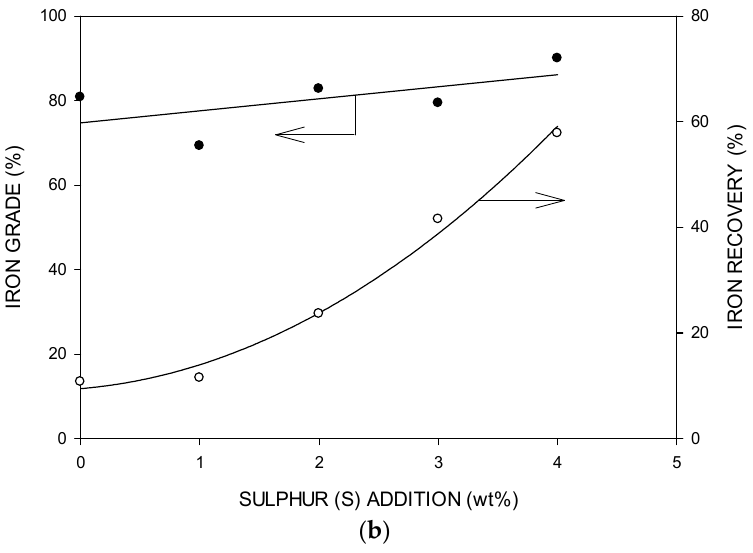
Figure 13. ( a ) Effect of sulphur additions on nickel grade and recovery at a magnetic field strength of 3 kG; ( b ) Effect of sulphur additions on the iron grade and recovery at a magnetic field strength of 3 kG.